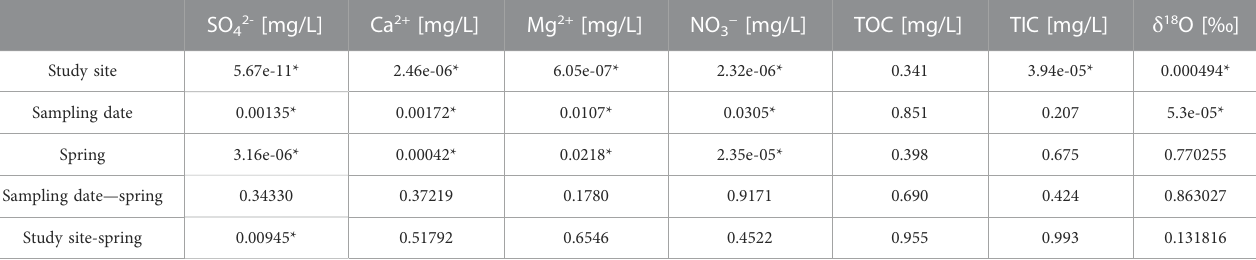
TABLE5 p -valuesofthethree-wayANOVAperformedonion/isotopicvaluesmeasuredinwatersamples.Asteriskindicatesthevaluesbelowthesigni fi cancelevelalpha ( α =